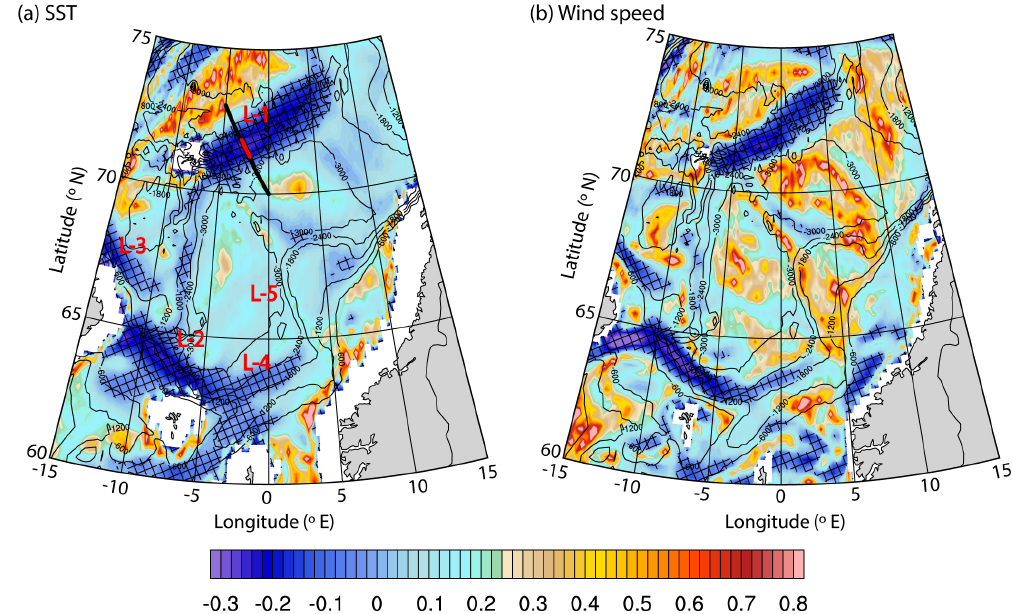
Figure 4. Singularity exponents estimated from the climatological mean (2002–2009) (a) AMSRE SST and (b) QuikSCat wind speed. Black isobaths are drawn for every 600m. In panel (a), the bold black line shows the location of the vertical section across the Mohn Ridge shown in Figs. 7, 8 and 10. The position of the core of the AF shown in Fig. 7 is marked as red over the bold black line. Locations 1, 2, 3, 4 and 5 are represented respectively by L-1, L-2, L-3, L-4 and L-5. Negative values are highlighted (black hatching).